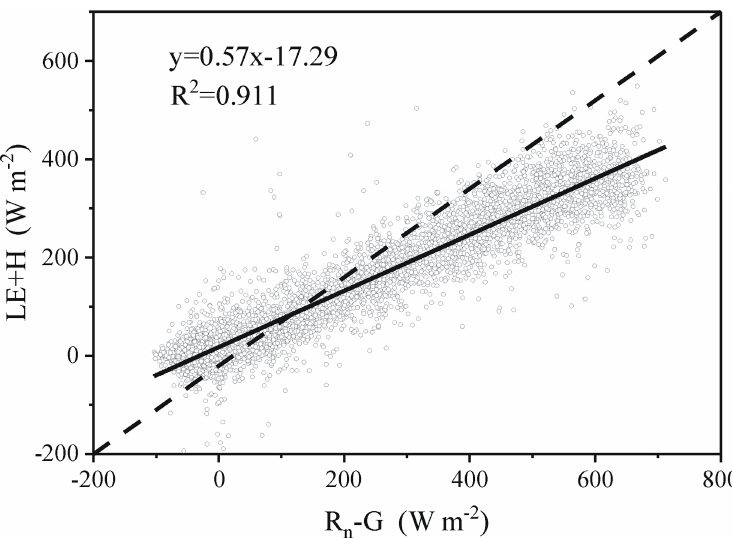
Fig 1. Energy-balance closure of cotton during entire growth period. The slope of the solid line represents the degree of energy balance closure. (R n is the net radiation, G the soil heat flux, LE is the latent heat flux, H is the sensible heat